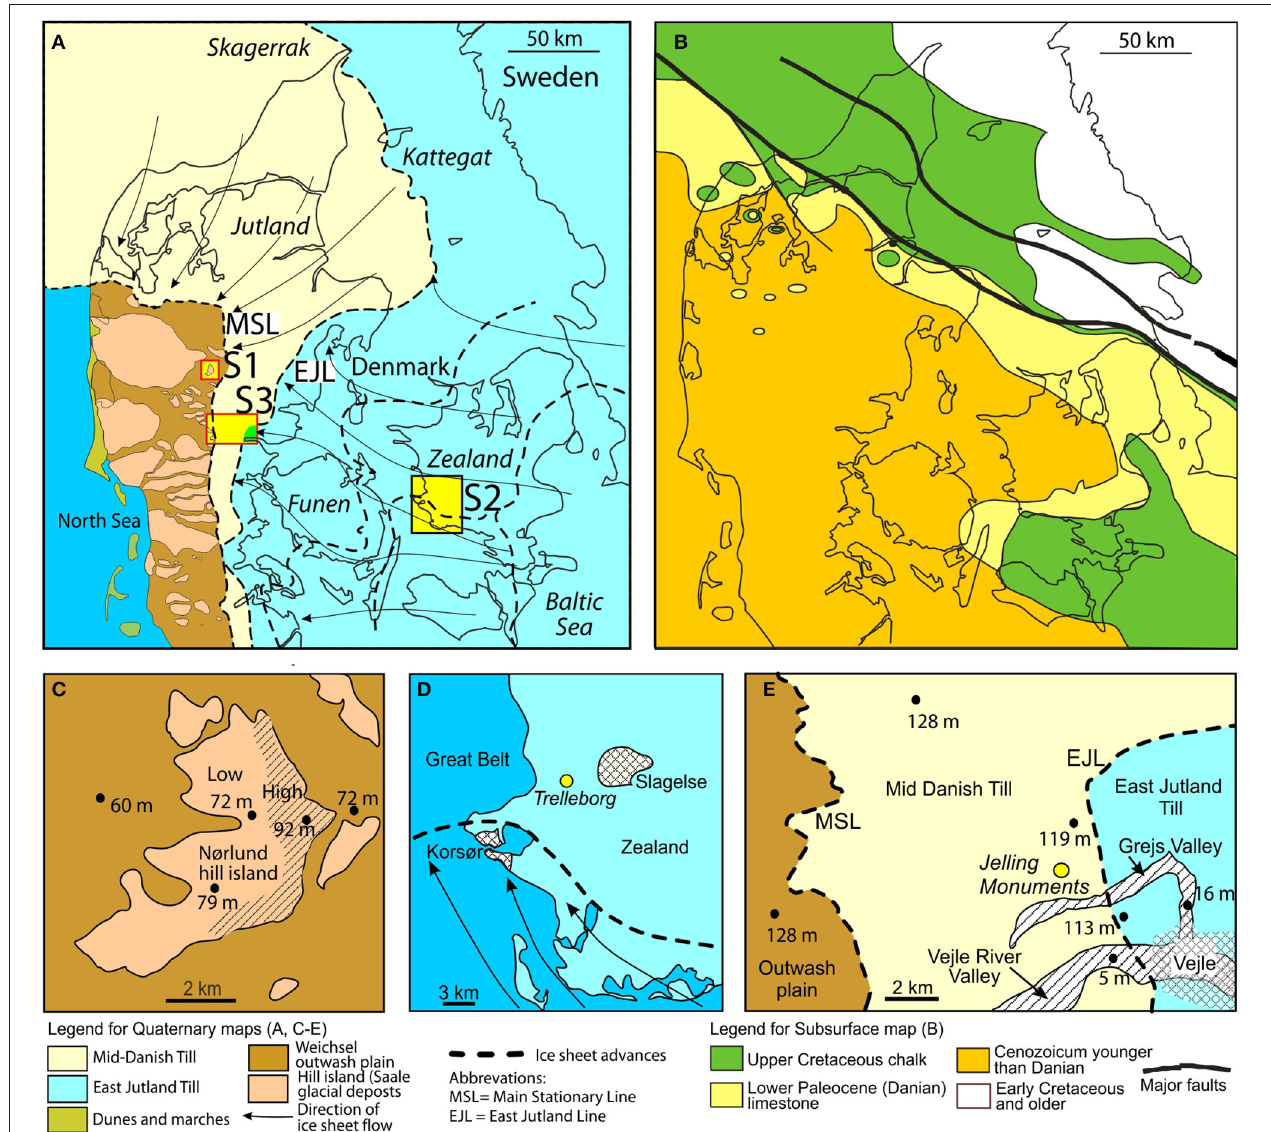
FIGURE 1 | Simplified geological maps of Denmark with study areas depicted. (A) Map showing main features of the Quaternary glacial deposits. The Main Stationary Line (MSL) and the East Jutland Line (EJL) indicate the maximum extent of the Weichselian ice sheet in Denmark and the maximum extent of the East Jutland Advance, respectively. The two lines subdivide Jutland into three glaciogenic provinces: West Jutland, Central Jutland, and East Jutland. The distribution in West Jutland of hill islands (Saale glacial deposits) and Weichselian outwash plains is indicated. Arrows indicate direction of ice movement during advances to the Main Stationary Line and East Jutland Line. Locations of study areas S1–S3 are shown. Map is based on Krüger (1983); Madsen et al. (1992), Kjær et al. (2003), and Smed (2013). (B) Map showing the distribution of pre-Quaternary deposits in Denmark. Note distribution of Cretaceous chalk and Lower Paleocene limestone. Map is based on Håkansson and Pedersen (1992). (C) Map showing main features of study area S1, Nørlund hill island. (D) Map showing main features of study area S2, SWZealand. (E) Map showing main features of study area S3,